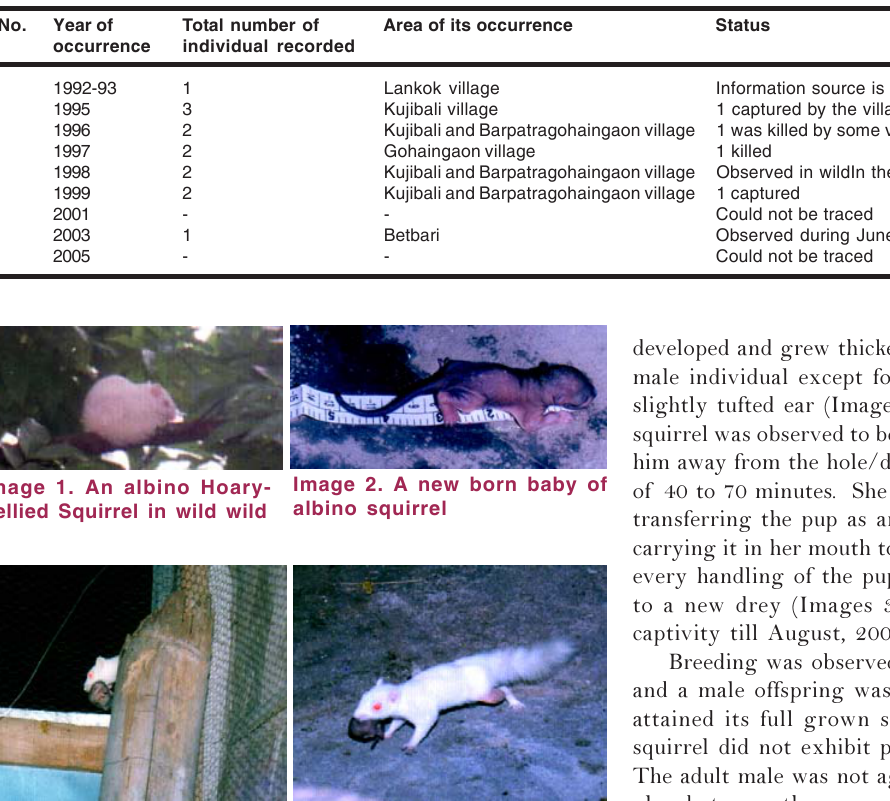
Table 1. Occurrence of albino Hoary-bellied Squirrel in villages of Sibsagar District surveyed during 1997-98 (Data based on local villagers’